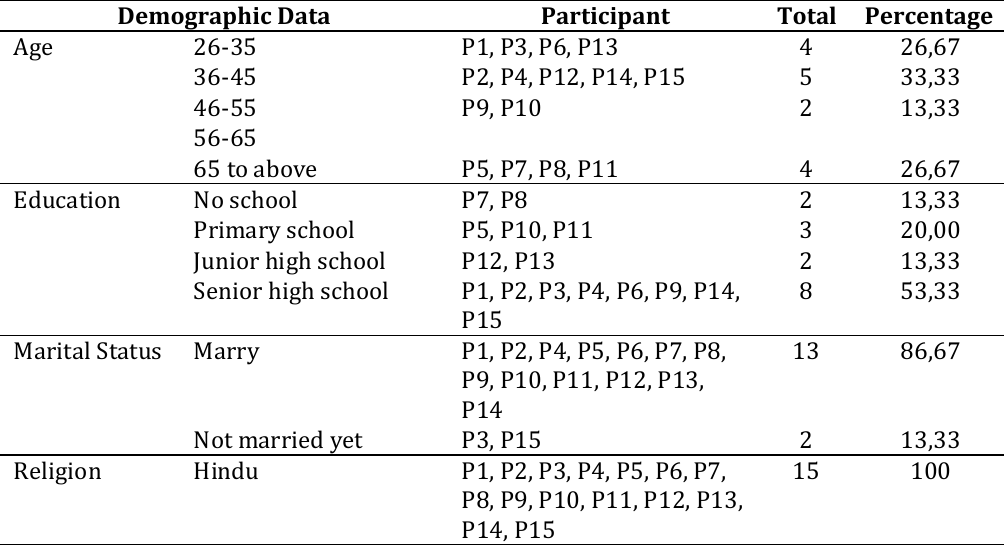
Characteristics of